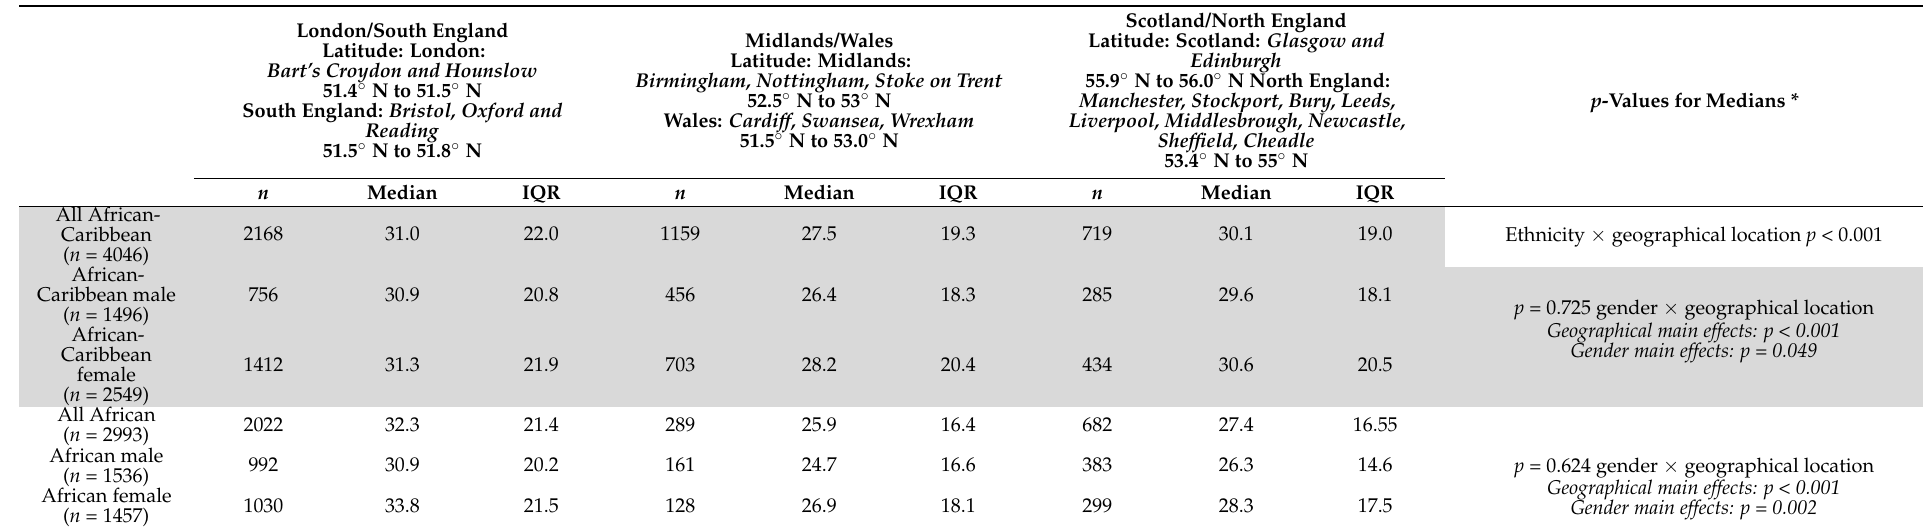
Table 4. 25(OH)D (nmol/L) by geographical location of the African-Caribbean ( n = 4046) and African ( n = 2993) UK Biobank participants. London/South England Latitude: